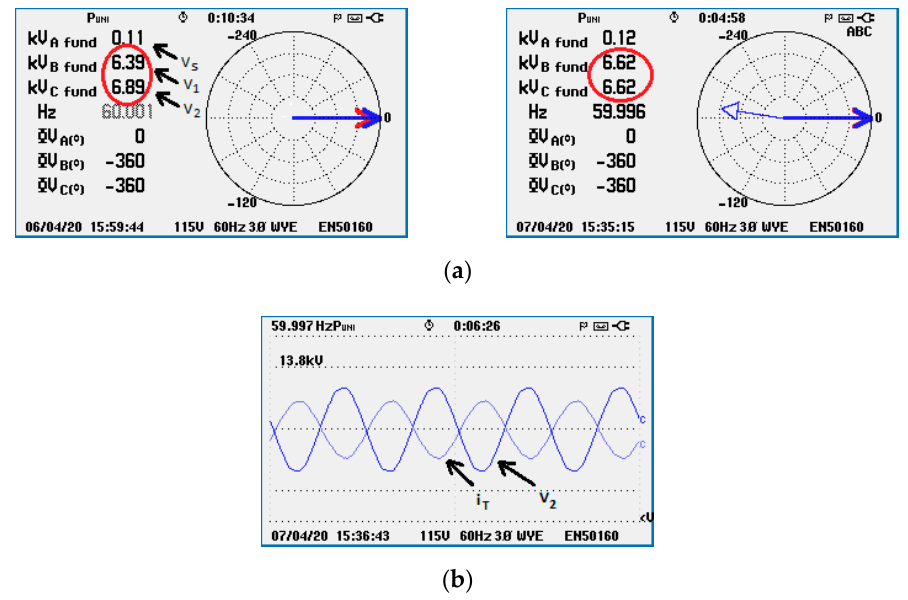
( b ) Figure 13. Simulation results with the series VSC operation; ( a ) V 1 and V 2 ; ( b ) transferred P and Q. For the radial configuration, in stage 2 (i.e., R 1 insertion) the feeder A terminal voltage V 1 drops from 7.4 kV to 6.4 kV and the feeder B terminal voltage V 2 also drops but slightly less than the first. In stage 3, R 1 was removed, returning the whole system to the initial voltage conditions. In stage 4, the inserted R 2 shows a V 2 voltage drop less than in stage 2 because feeder B is stronger than feeder A. Stage 5 ends the resistive test by removing load R 2 that returns the terminal voltages to the initial voltage conditions. Figure 12b shows the active and reactive power values transferred in the loop. Stage 2 ( R 1 insertion) shows the transferred power from feeder B to feeder A, which consequently improves the terminal voltages by an intermediate value via power transfer. Stage 4 ( R 2 insertion), shows the power transfer from feeder A to feeder B, also improving the terminal voltages more than in the radial configuration. This shows the power transfer